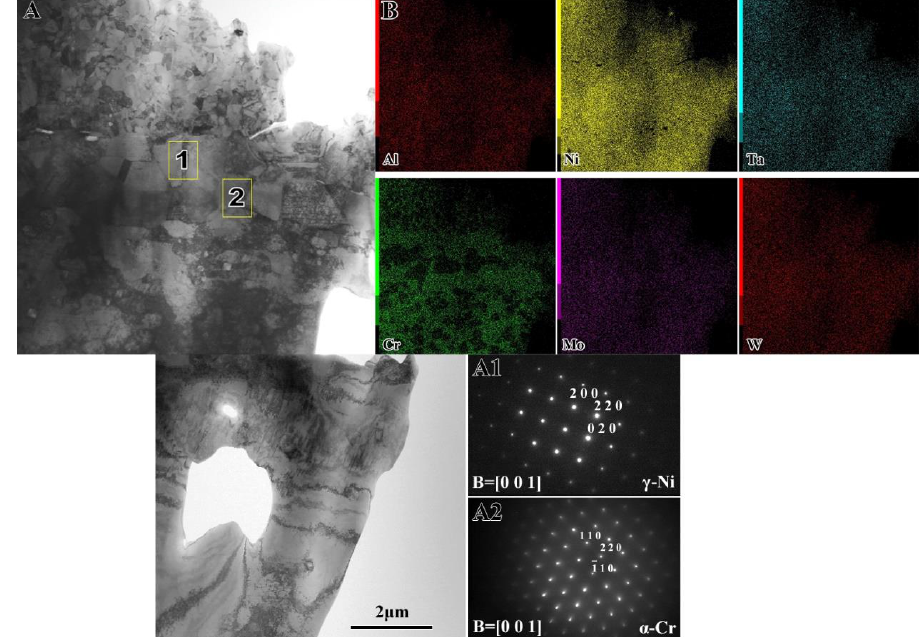
Figure 11. TEM bright field image ( A ) and elemental maps ( B ) displayed the microstructure of the interface between SN-N5 coating/substrate after oxidation at 1050 °C in air for 500 h. ( A1 , A2 ) were the SAED patterns obtained at the areas denoted as 1 and 2 in ( A ).